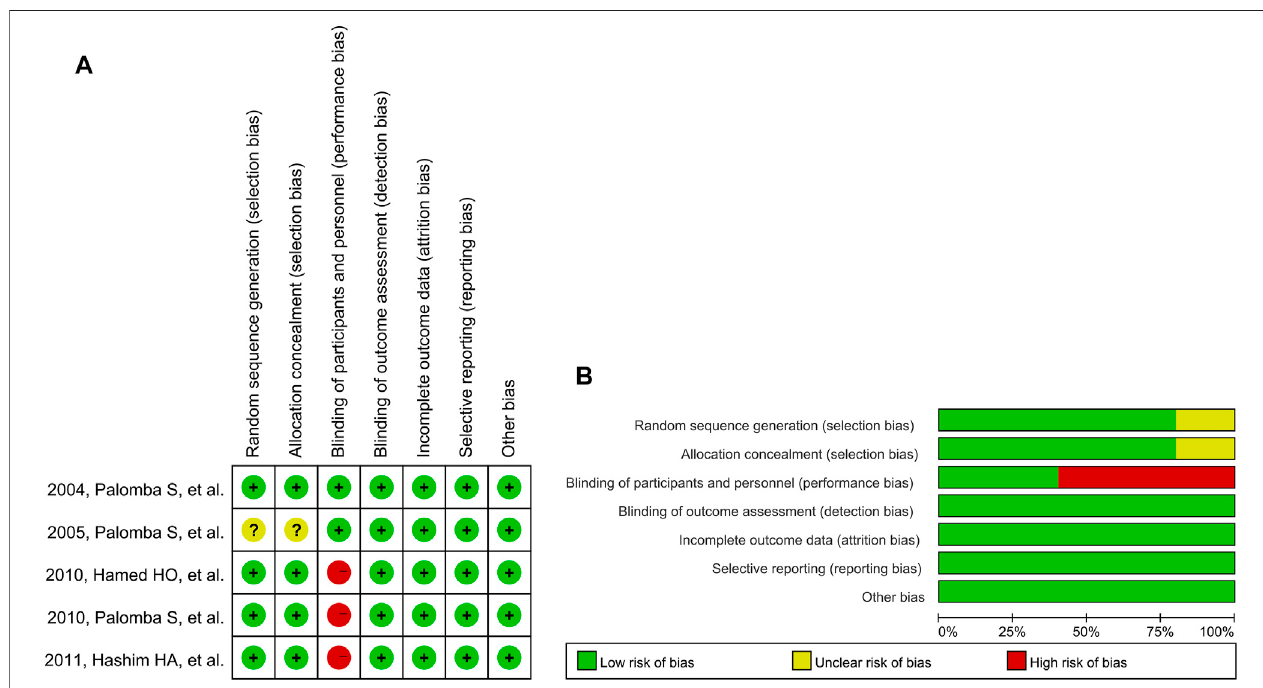
FIGURE 2 | Risk of bias graph for reviewing authors ’ judgements: (A) Individual studies, and (B) All studies. Note: The colors have the same meaning in both (A) and (B) .